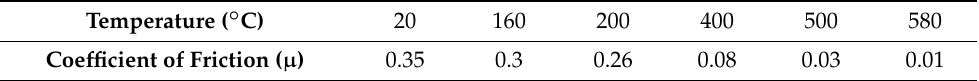
Table 1. Temperature-dependent friction coefficient between steel and aluminium